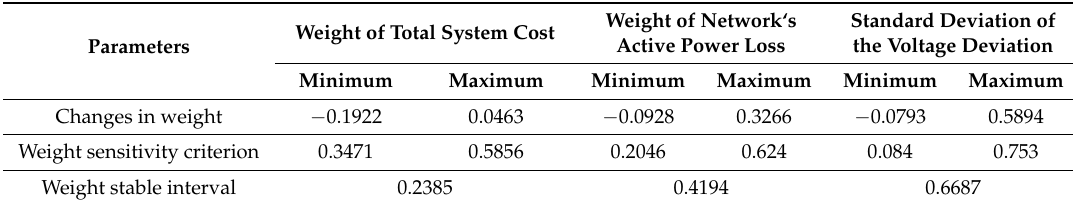
Table 7. Weight sensitivity analysis in the objective function of the upper distribution